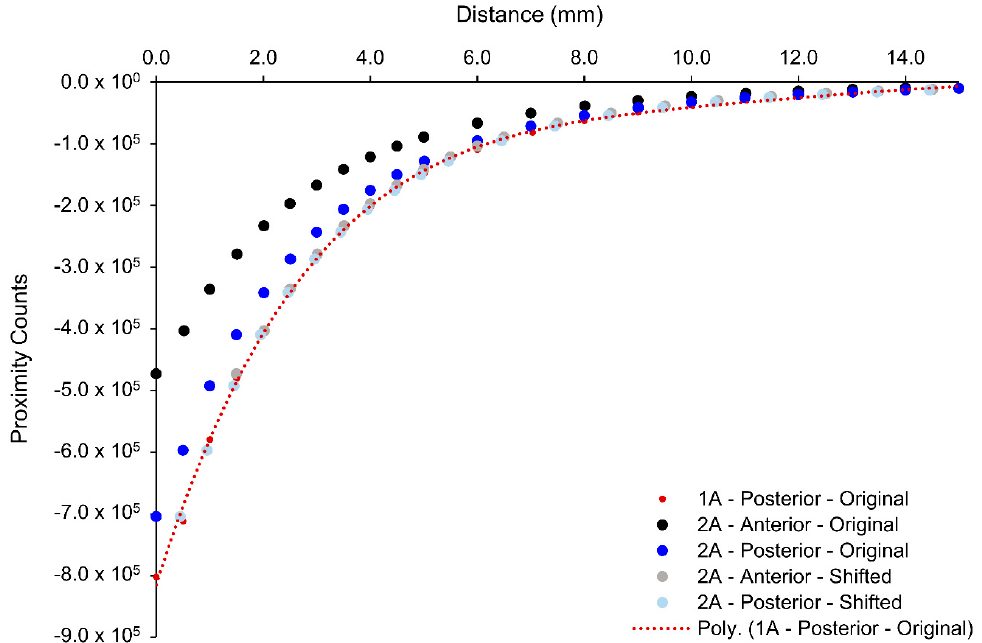
Figure A5. Liner repeatability evaluations. Sensitivity curves aligned well after an x-axis offset was applied.